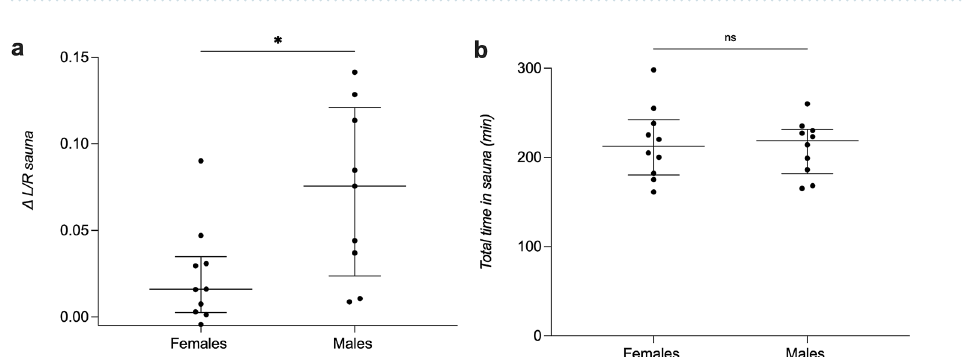
Figure 5. Differences between female and male participants. ( a ) Small intestinal permeability shown as ∆ L/R (L/R sauna–L/R control). ( b ) Total time in sauna until loss of 3% body weight. The horizontal line marks the median, the vertical line spans through the interquartile range (IQR). The dots represent the individuals.* P < 0.05. ns,